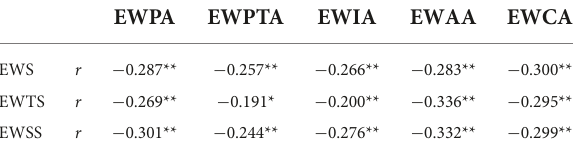
TABLE 3 Results of the correlation analysis between English writing self-efficacy and psychological anxiety. EWPA EWPTA